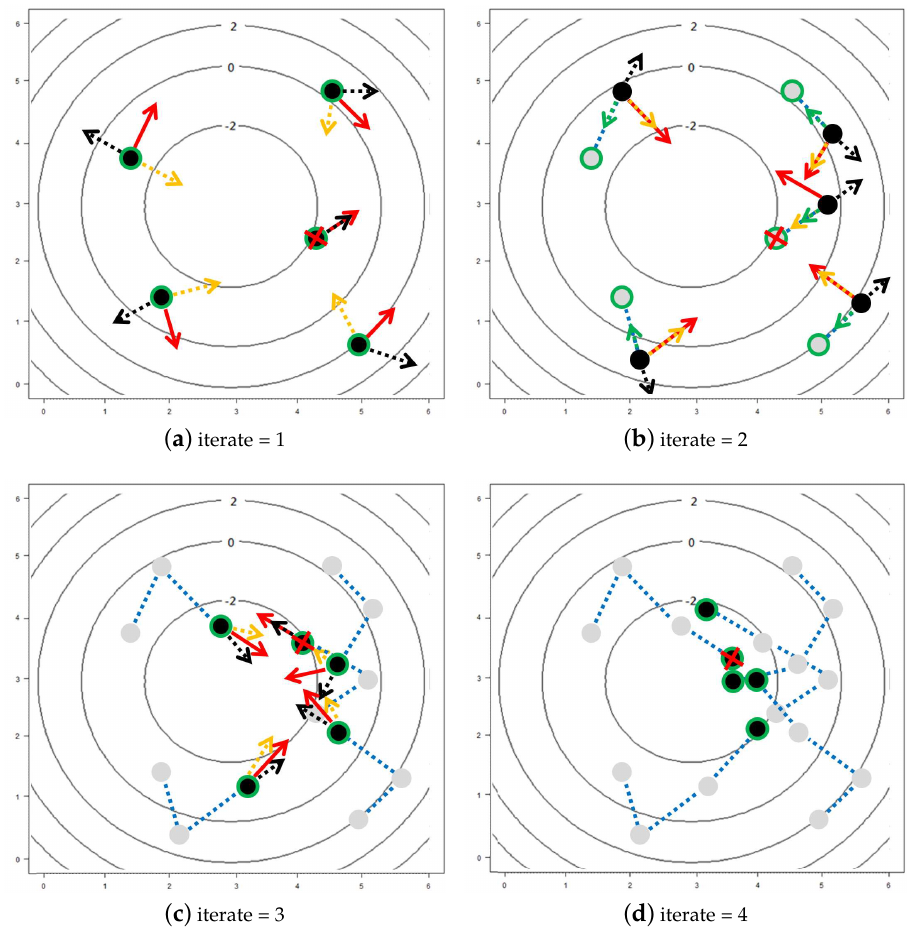
Figure 4. A schematic diagram of the Particle Swarm Optimization (PSO) algorithm with 5 particles in the first 4 iterations, where black points denote the current positions of the particles, gray points combined with dashed lines denote the corresponding path of each particle, and the red arrows denote the velocity of each particle determined by the black, green, and yellow dotted-arrows, which represent the three directions of the components on the right-hand side of (8). In the t -th iteration, the points with green circle denote P t for i = 1, . . . ,5, and the point with red cross denotes G t , t = 1, . . . ,4, where P t i and G t are defined in (8).